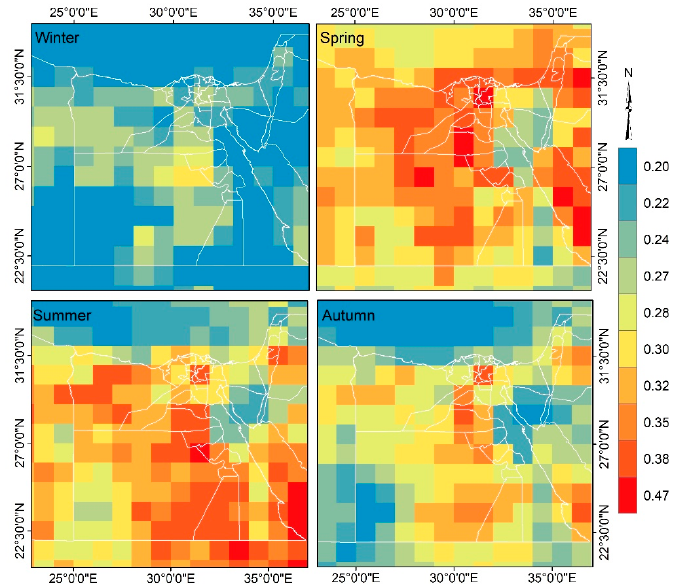
Figure 7. Seasonal variations of AOD over Egypt using level 3 combined Dark Target (DT) and Deep Blue (DB) MODIS Terra data at 550 nm; data are averaged for winter (DJF), spring (MAM), summer (JJA), autumn (SON) during 2012–2018.